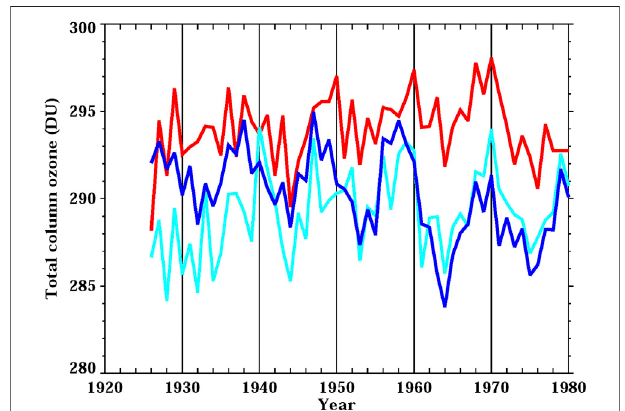
FIGURE 9 | Evolution of the near-global mean TCO obtained from the HISTOZ data set (red line) and retrieved from proxies without (blue line) and with Arosa/Davos TCO as an additional proxy (light blue line). The correlation coef fi cients with HISTOZ data are 0.31 and 0.56 for the cases without and with Arosa/Davos TCO.